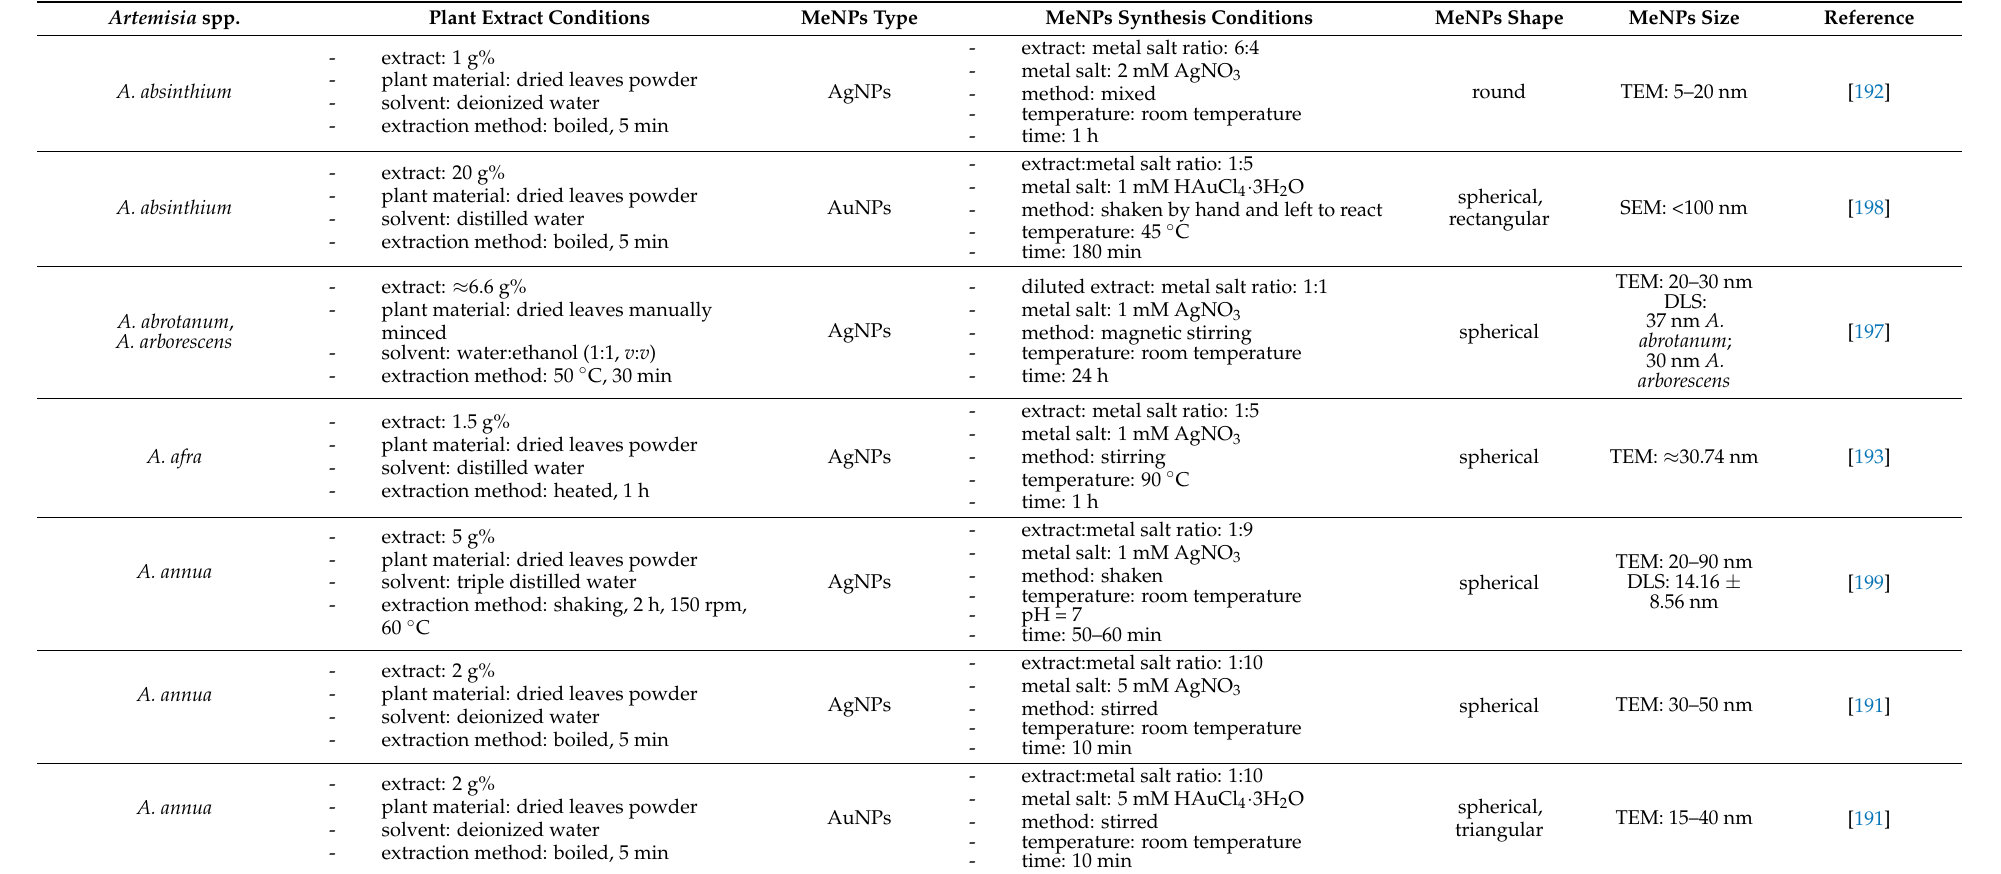
Table 4. Artemisia spp. as sources of AgNPs and